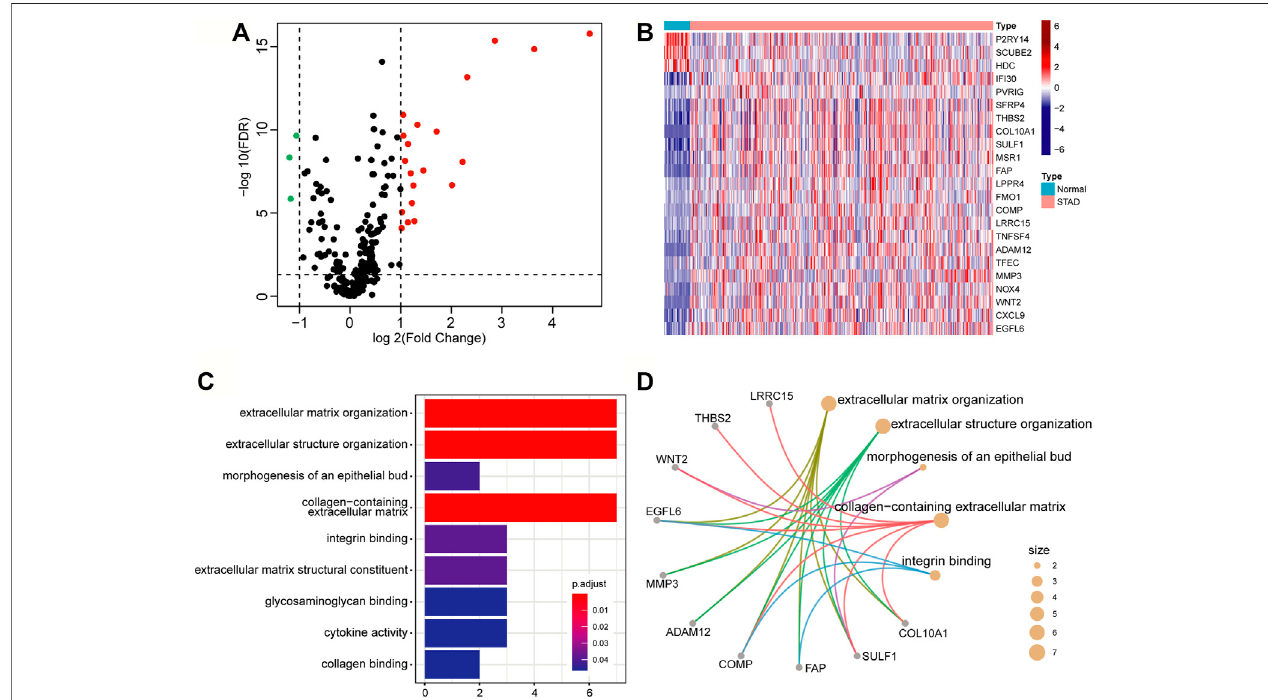
FIGURE 2 | Differentially expressed genes related to the tumor microenvironment. (A) The volcano map of the TME-related differential expressed genes. The screening criteria were |log2(Fold Change)| > 1 and FDR < 0.05. The red, green, and black points represent genes that were signi fi cantly up-regulated, down-regulated, and insigni fi cant. (B) Heatmap of signi fi cantly TME-related differentially expressed genes. (C) Bar graph of GO enrichment analysis of signi fi cantly TME-related differentially expressed genes. (D) The main terms and related genes for GO enrichment analysis. The size of the circle corresponds to the number of genes annotated to the